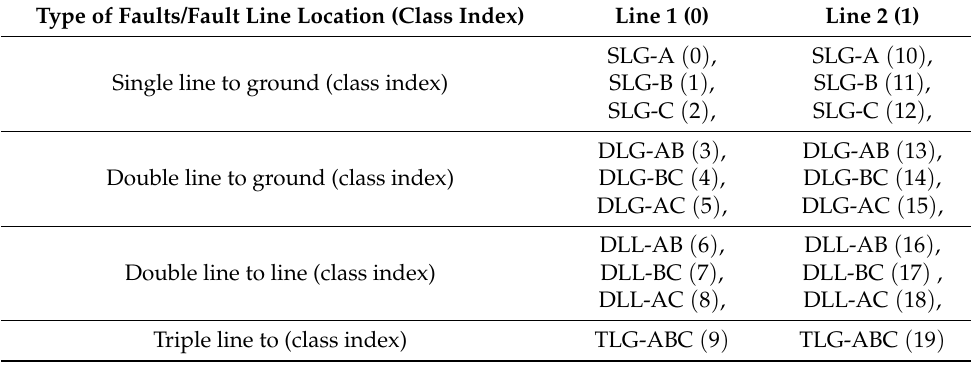
Table 2. Types of power system